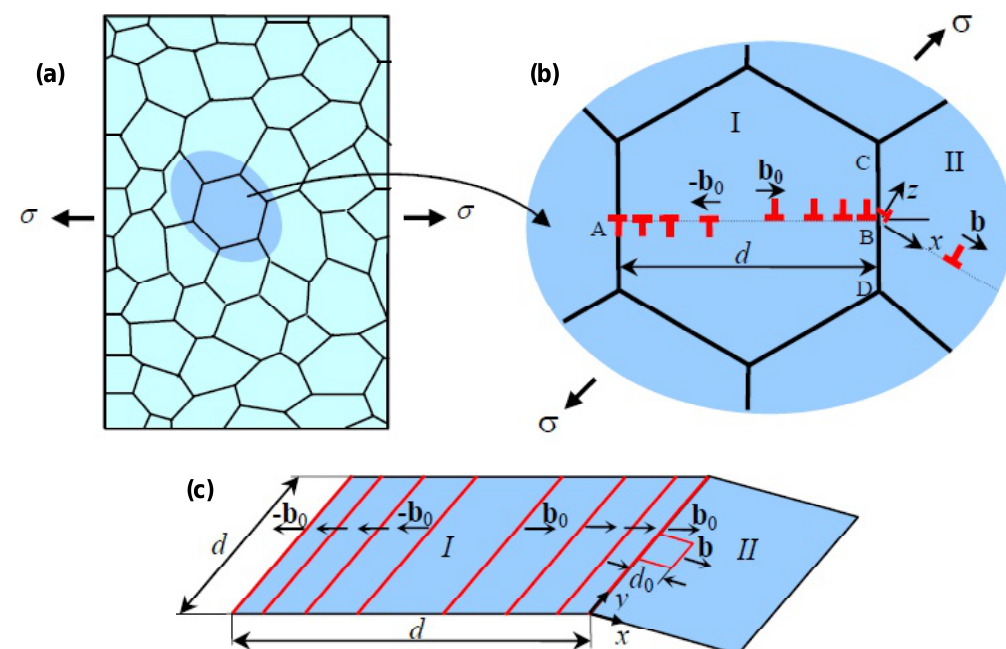
Fig. 1. Dislocation transmission across a grain boundary in polycrystalline metals. (a) Polycrystalline metallic specimen under uniaxial tensile loading. (b) Magnified fragment of figure (a) rotated by 45 ° high- lights dislocation transmission across grain boundary CD in the stress field of the applied load  and double dislocation pileup AB. (c) Dislocation transmission is illustrated in the plane normal to that shown in Figure (b), where the lines of the pileup dislocations and dislocation loop in grain II can be